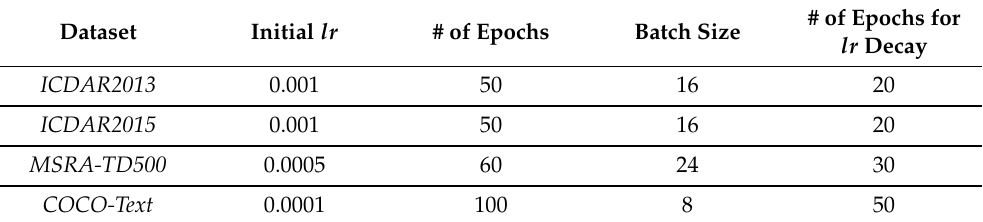
Table 1. MobileTDNet hyperparameters: lr represents the learning rate.